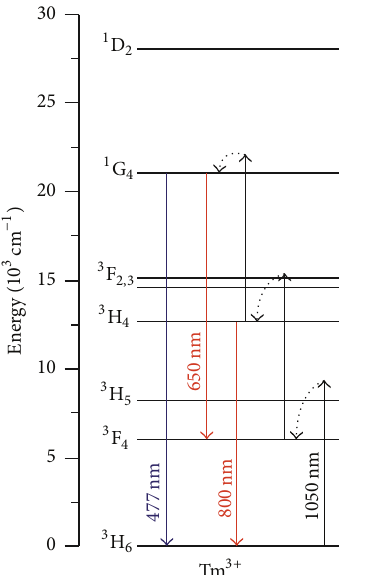
Figure 13: Absorption spectra of TBW-Er:Ag glasses for different heat-treatment times [4].